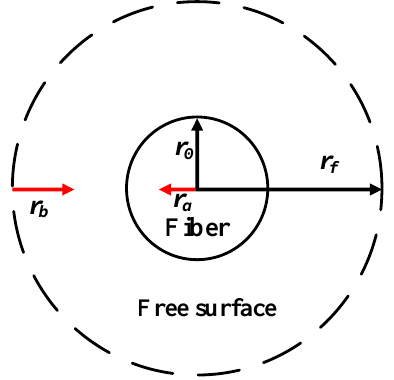
Figure 1. A scheme for the free surface model.